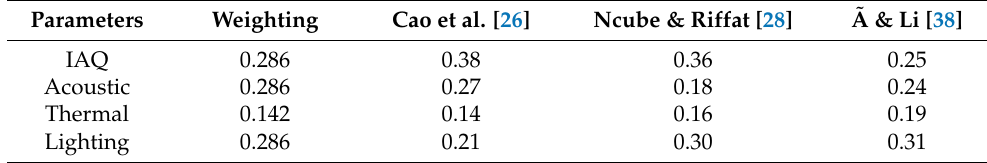
Table 3. The weighting of IEQ parameters compared with the